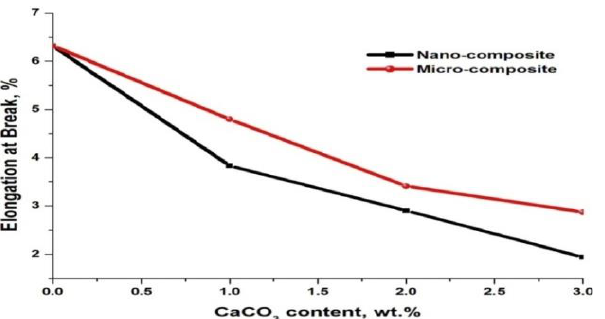
Fig. 11. Comparison of predicted Young’s modulus from Guth’s equation to experimental data: micro- and nano-composites..